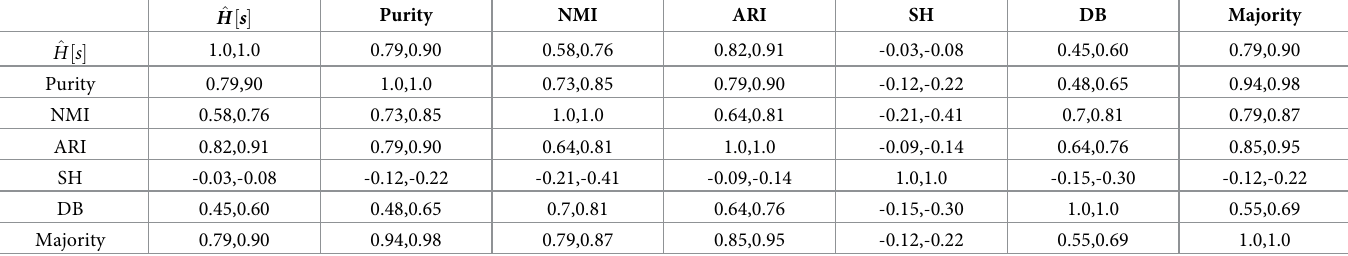
Table 2. Kendall’s Tau and Spearman correlation for stock considering SEC codes at 2 digits. The correlation between the majority ranking and ^ H ½ s � ranking (top- right boxed entry) is reported in the last column of Table 1, whereas the average of the correlations between rankings provided by the different measures (underlined entries) is reported in the d 1 - d 2 column of Table 1 for all datasets.